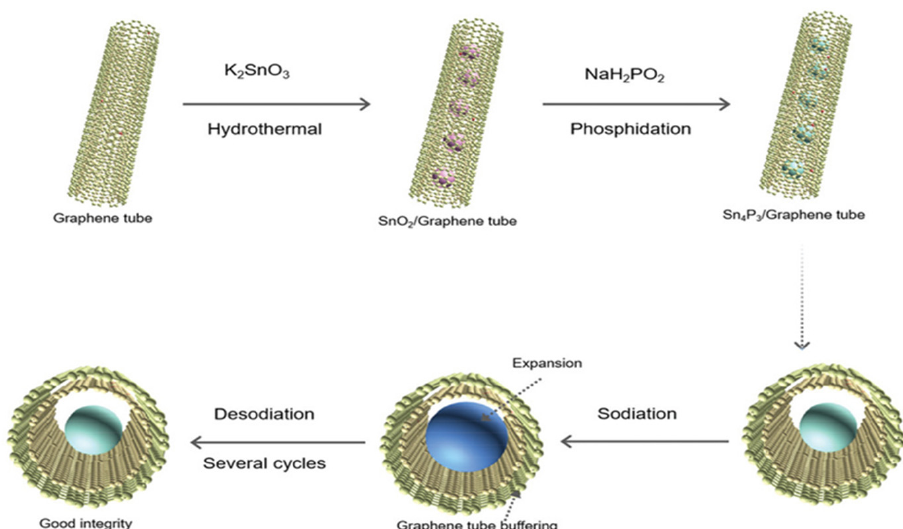
Figure 16. The fabrication steps the nanocomposite of Sn 4 P 3 /GT. The schematic illustration shows that the SnO 2 nanoparticles were firstly prepared in the inside of the graphene tube by selective growth of hydrothermal method and then a phosphidation process was used to form Sn 4 P 3 /GT; the following three diagrams depict the sodiation/desodiation process of Sn 4 P 3 . Reproduced with permission [58]. Copyright 2021,